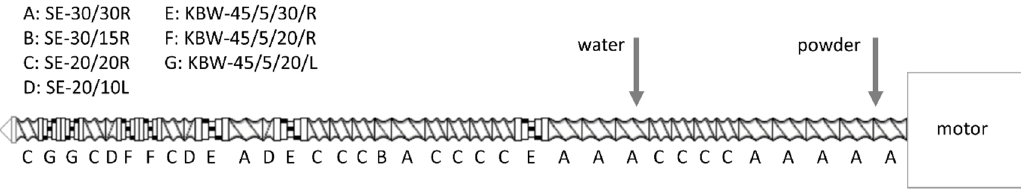
Figure 1. Screw configuration. The screw diameter is 20 mm. Single letters correspond to the manufacturer’s screw part codes as presented in the top left corner, where SE—conveying element, KBW—kneading block, R—forward element, L—reverse element, and numbers encode angle (KBW only), step and element lengths in mm.